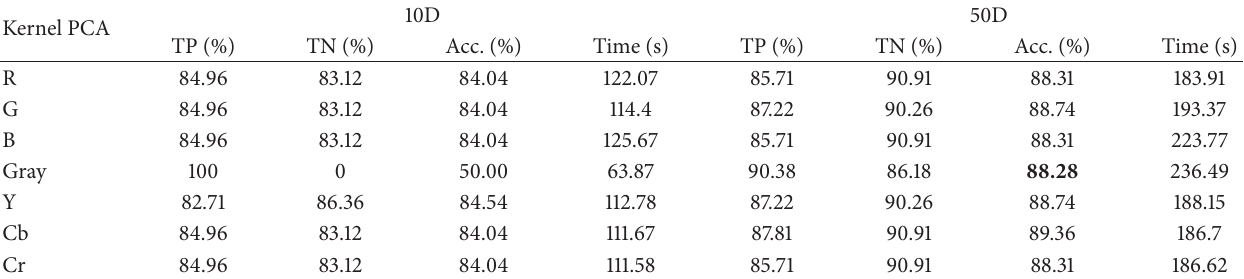
Table 3: Detection accuracy and computational time for RLRN with kernel PCA in 10D and 50D. Kernel